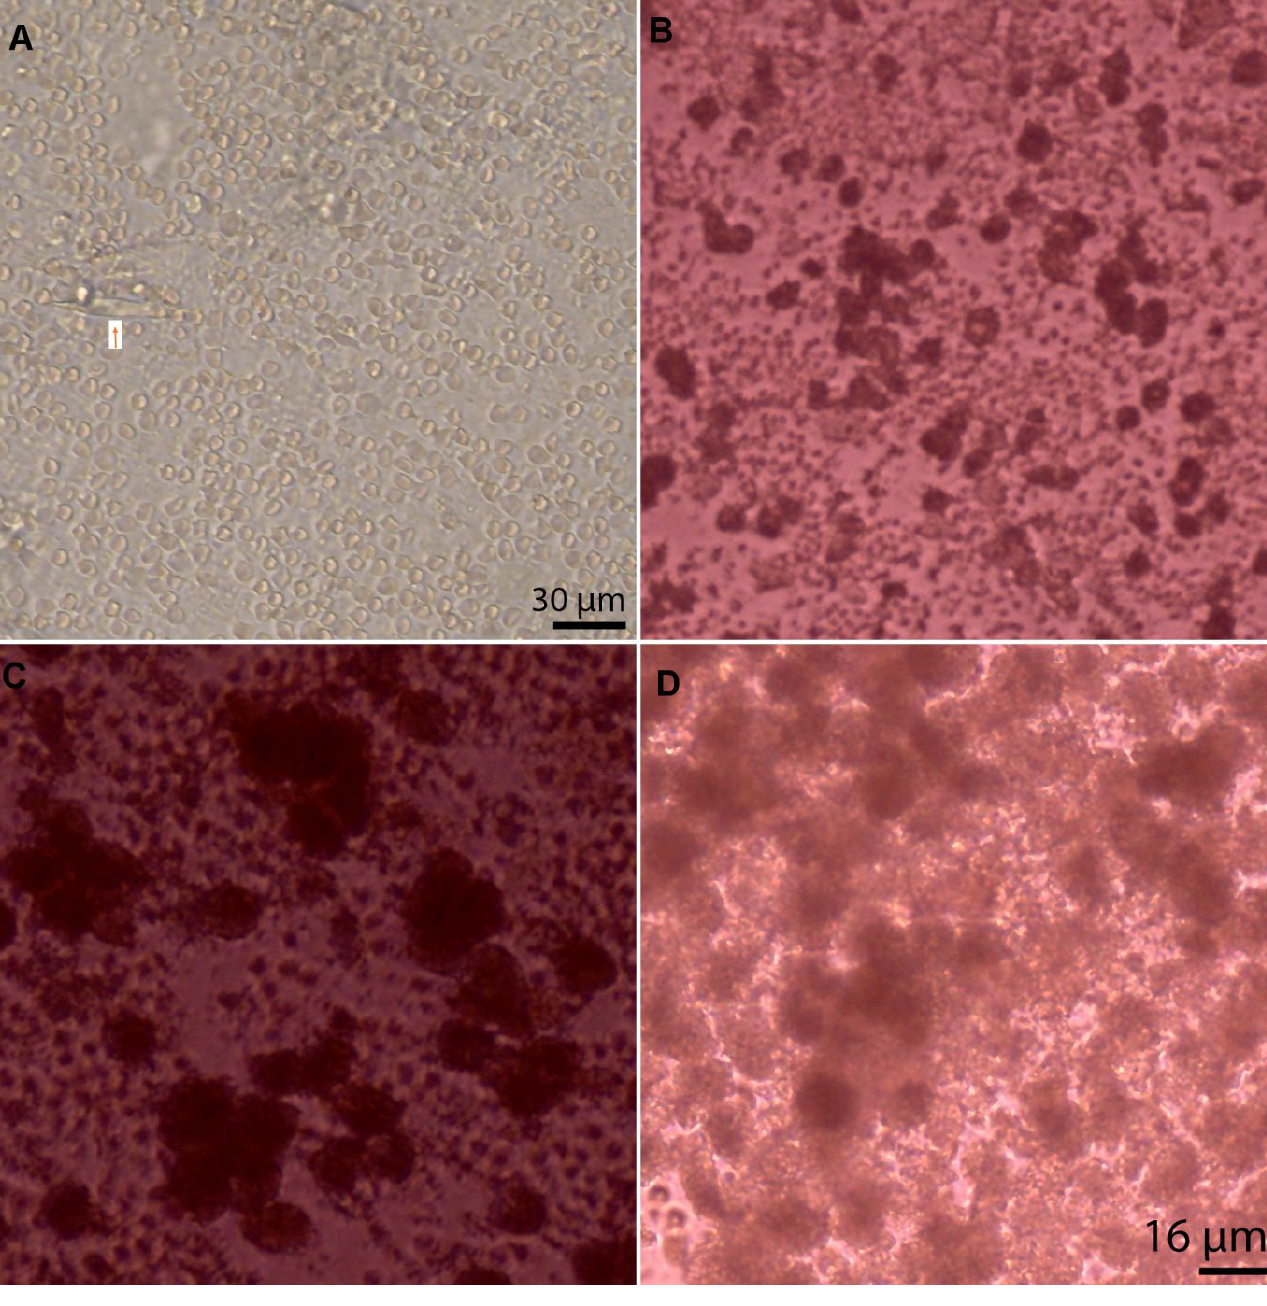
Figure 4. Harvest from each lesion demonstrating different quantity and type of cells being extracted. ( A ) Cell extract 24 h post culture prior to spin reveals a mixture of different cell types. Arrow points towards a fibroblast (20× zoom); ( B ) 2 days post culture; ( C ) 4 days post culture; ( D ) 6 days post culture (40× zoom).